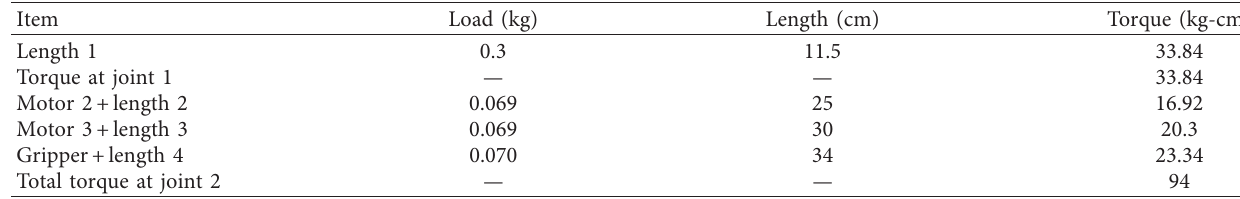
Figure 11: Position of robot joints during pick-and-place task. Table 3: Torque calculations based on different weights.